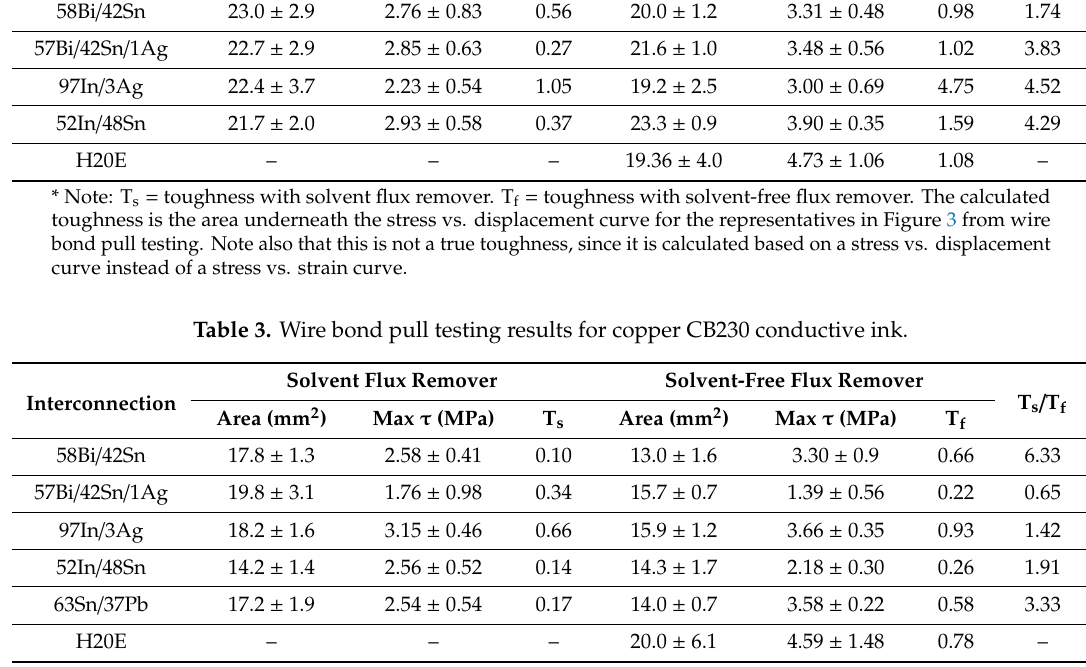
◦ Figure A2. High g testing was performed at 17 to induce both shear and normal forces, as depicted in Figure 2. The maximum acceleration and pulse width were recorded for each test. The resistance was